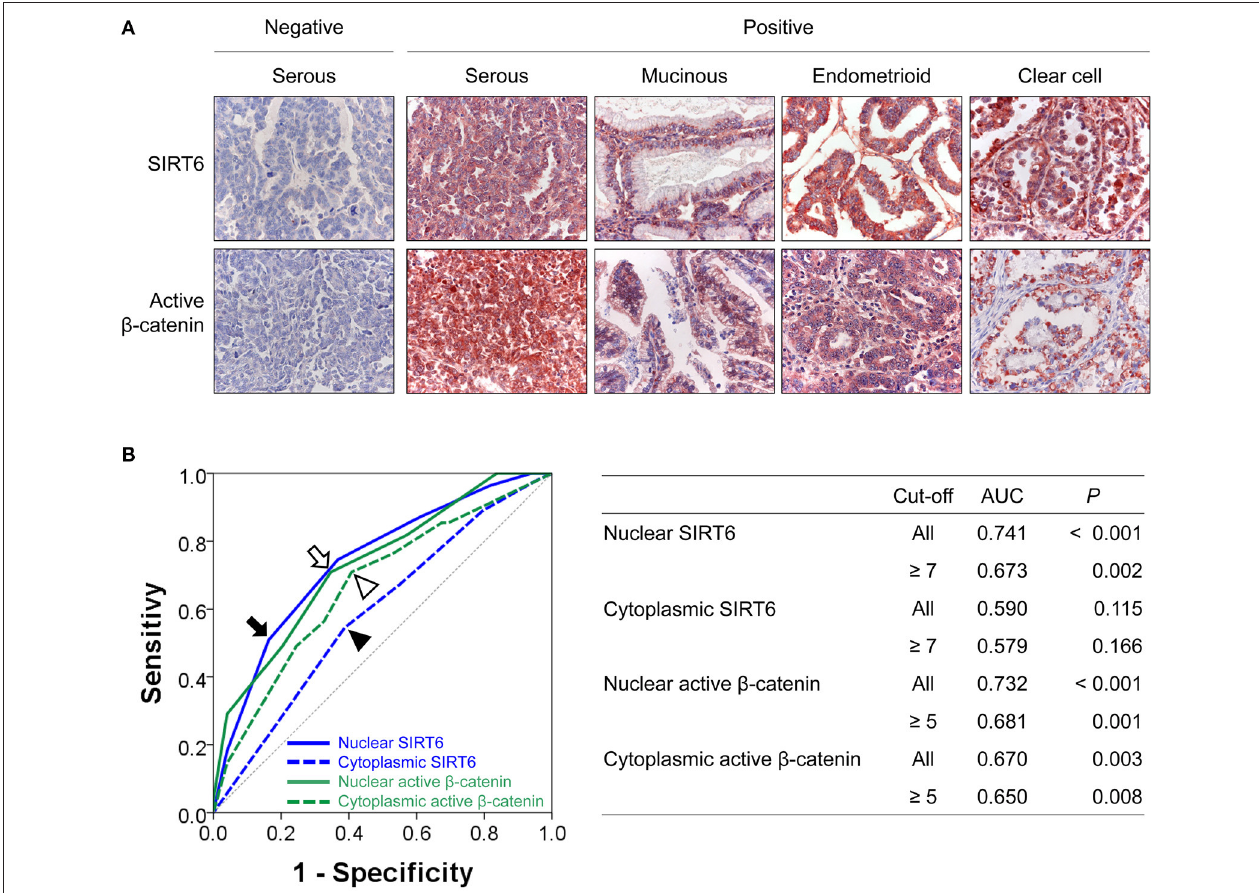
FIGURE 1 | Immunohistochemical expressions of SIRT6 and active β -catenin, and statistical analysis in ovarian carcinomas. (A) Immunohistochemical expressions of SIRT6 and active β -catenin are seen in both the cytoplasm and nuclei of tumor cells. (B) Receiver operator characteristic curve analysis to determine the cut-off points for the immunohistochemical staining for SIRT6 and active β -catenin. The cut-off points were determined at the highest area under the curve (AUC) value. The cut-off points for nuclear expression of SIRT6 (arrow), cytoplasmic expression of SIRT6 (arrow head), nuclear expression of active β -catenin (empty head), and cytoplasmic expression of active β -catenin (empty arrow head) were seven, seven, five, and five, respectively. The table shows AUC and P values at cut-off points for the nuclear and cytoplasmic expressions of SIRT6 and active β